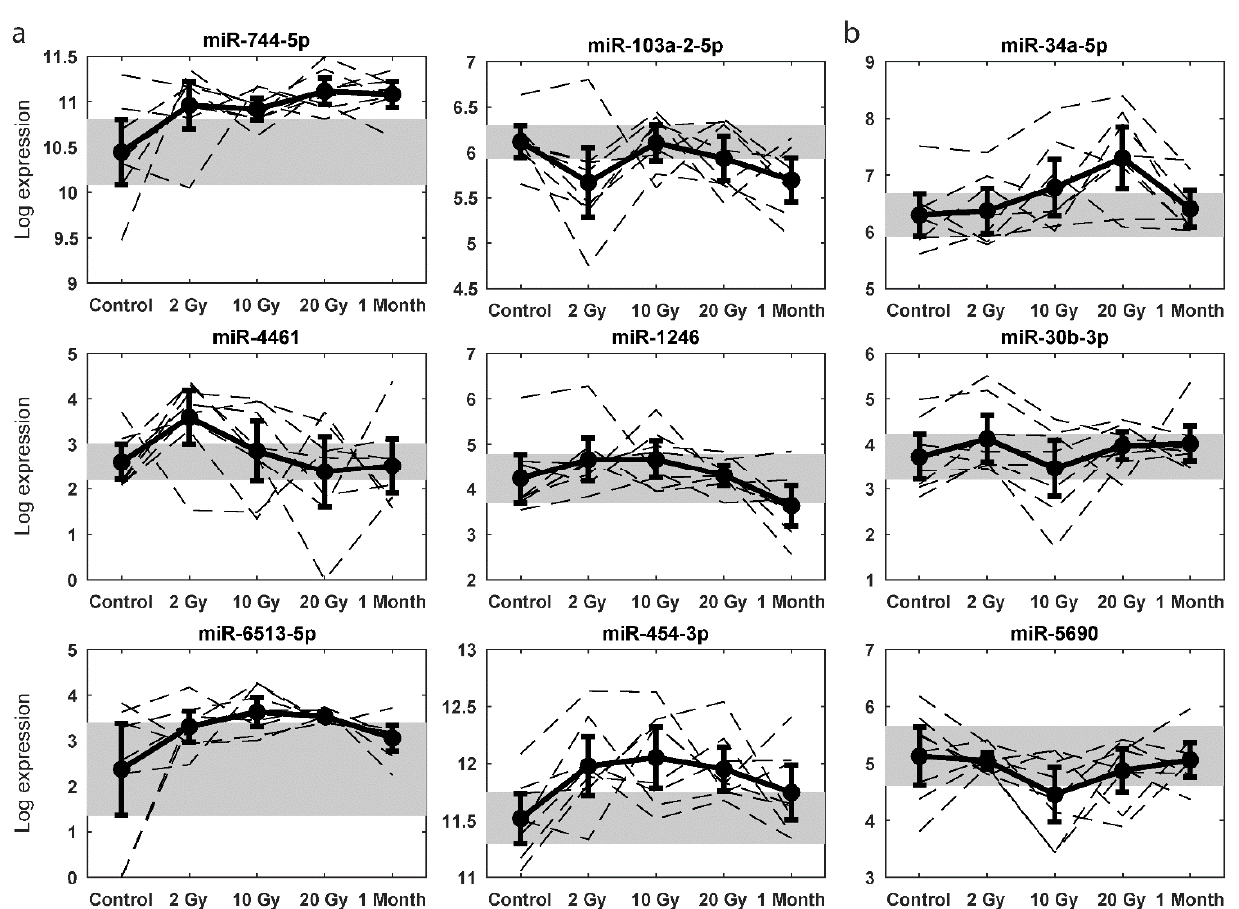
Figure 3. Selected target miRNAs based on model building from the training set ( a ) and the validation set ( b ). Dotted lines show expression values in individual patients, while the bold, solid line is the average expression across patients with 95% confidence intervals. Grey areas represent confidence intervals of average expression for the controls.